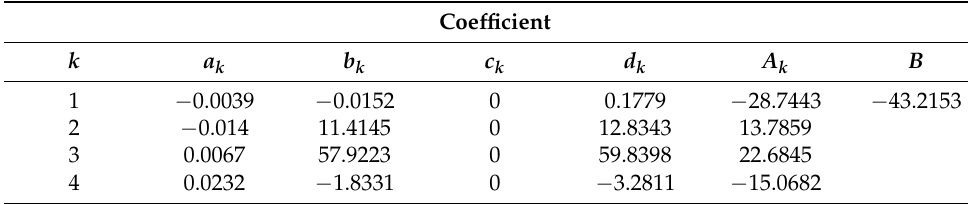
Table 5. Coefficient of Equation (8) for ANN3 model.